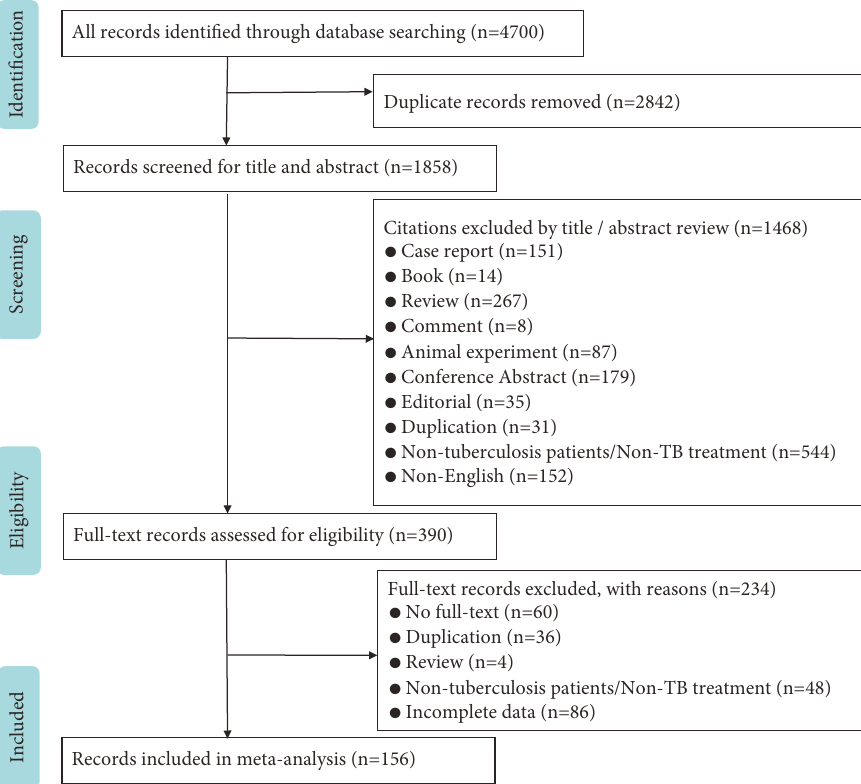
Figure 1: Flow diagram of study inclusion.